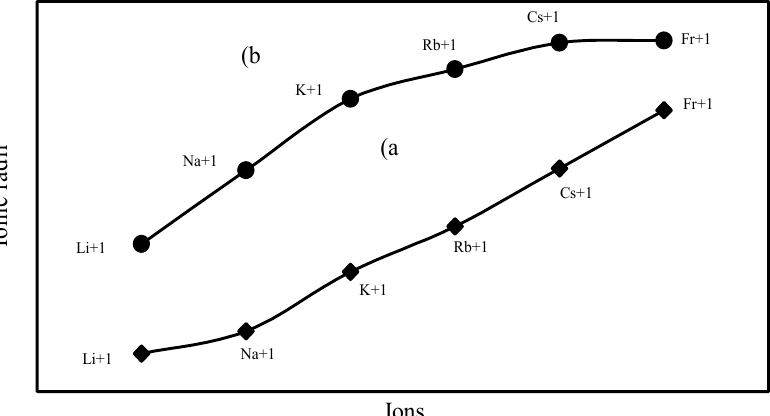
Figure 1. Plot of radii of monopositive ions of Gr-IA